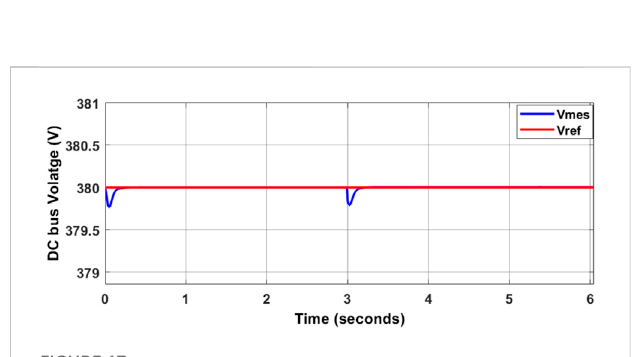
FIGURE 17 The obtained result of the DC bus voltage under various irradiance and load conditions.